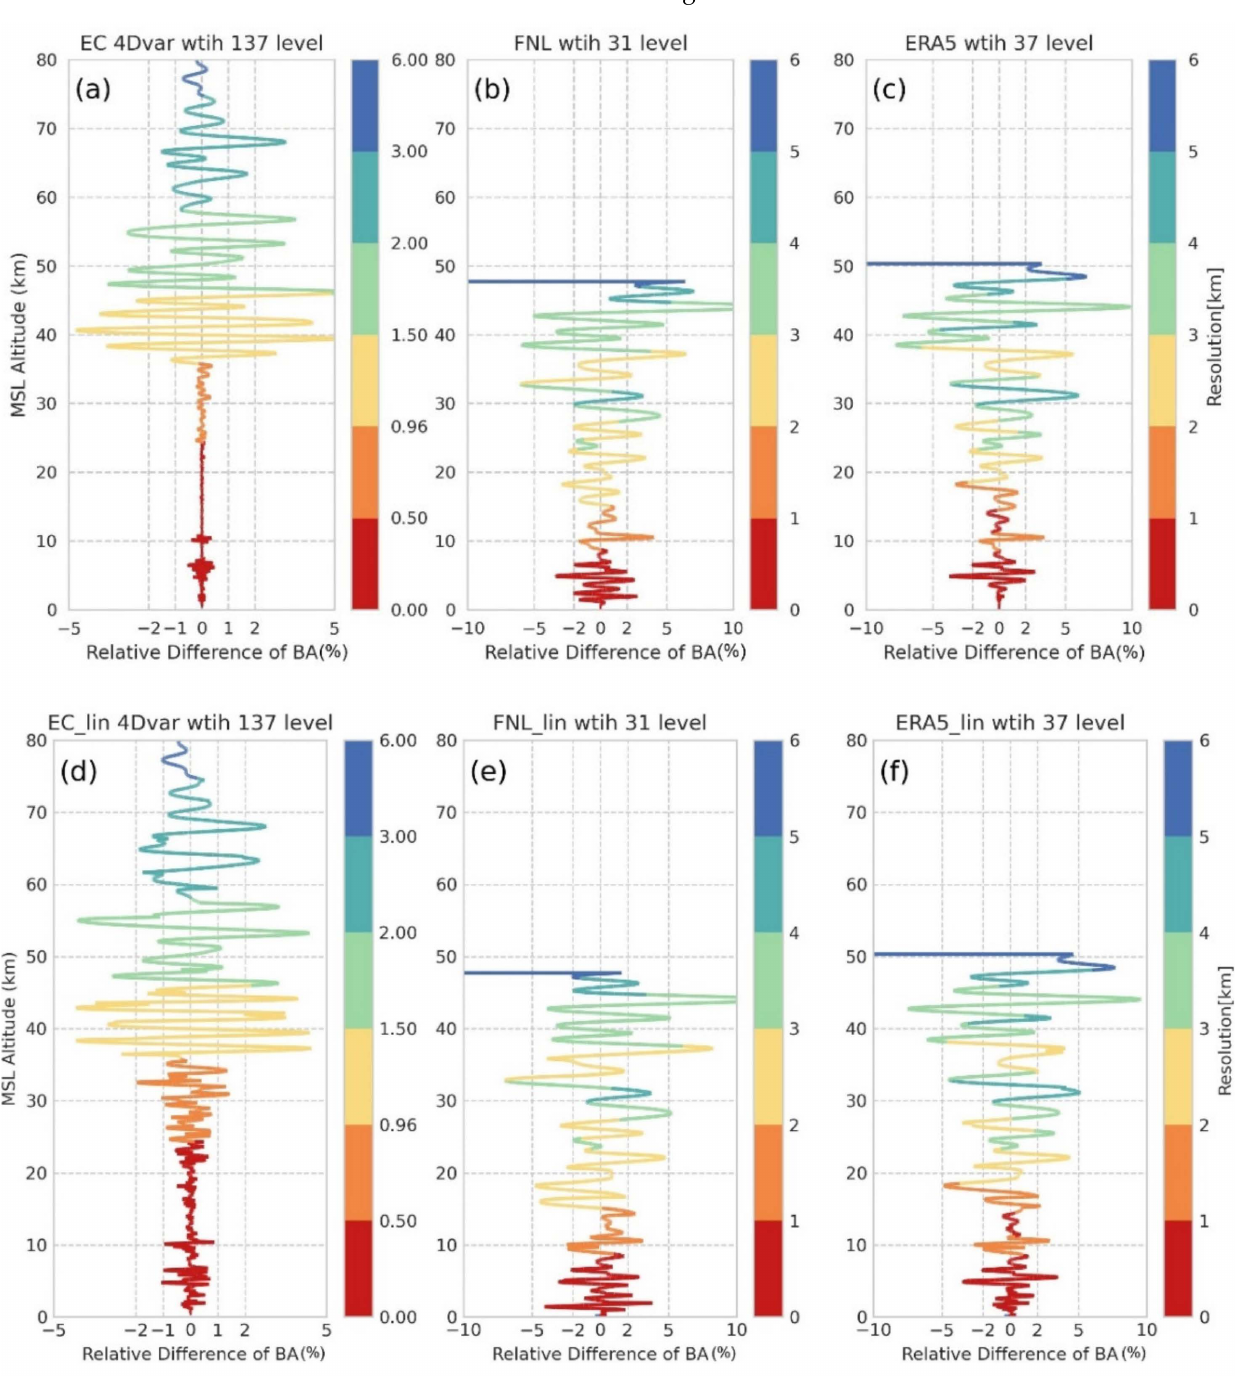
Figure 6. Effects of various model level intervals (km) on the FM error. The x-axis represents the RD, ((E − T)/T × 100%), of the BA between true value (T) and three simulated analyses (E): ( a , d ) 137 levels of EC4Dvar; ( b , e ) 31 levels of FNL; ( c , f ) 37 levels of ERA5. The FM is the exp algorithm, together with ( a – c ) log-cubic or ( d – f )